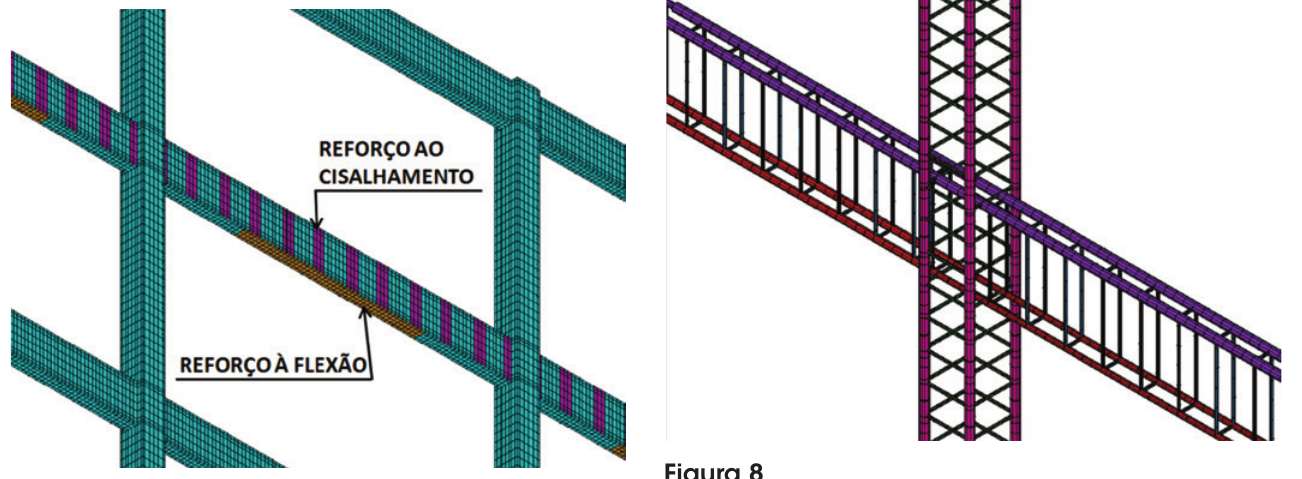
Figura 7 Posicionamento do reforço com PRFC – vista